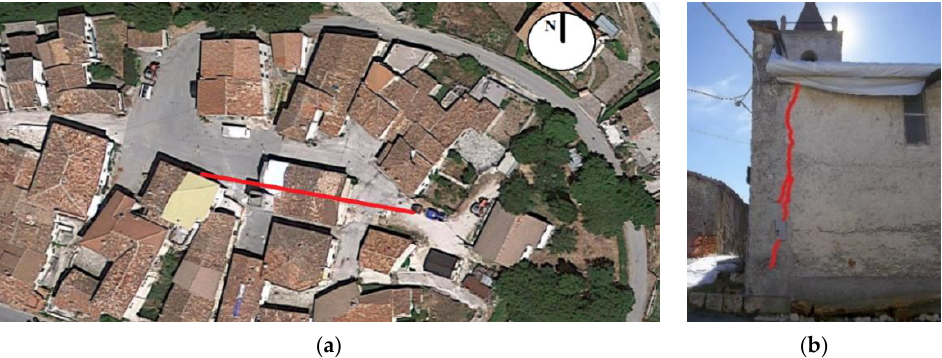
Figure 15. St. George church in Terracino (Accumoli): ( a ) aerial photography (adapted from Google Maps) with east – west axis orientation (red line); ( b ) façade overturning mechanism (cracks empha- sized in red).